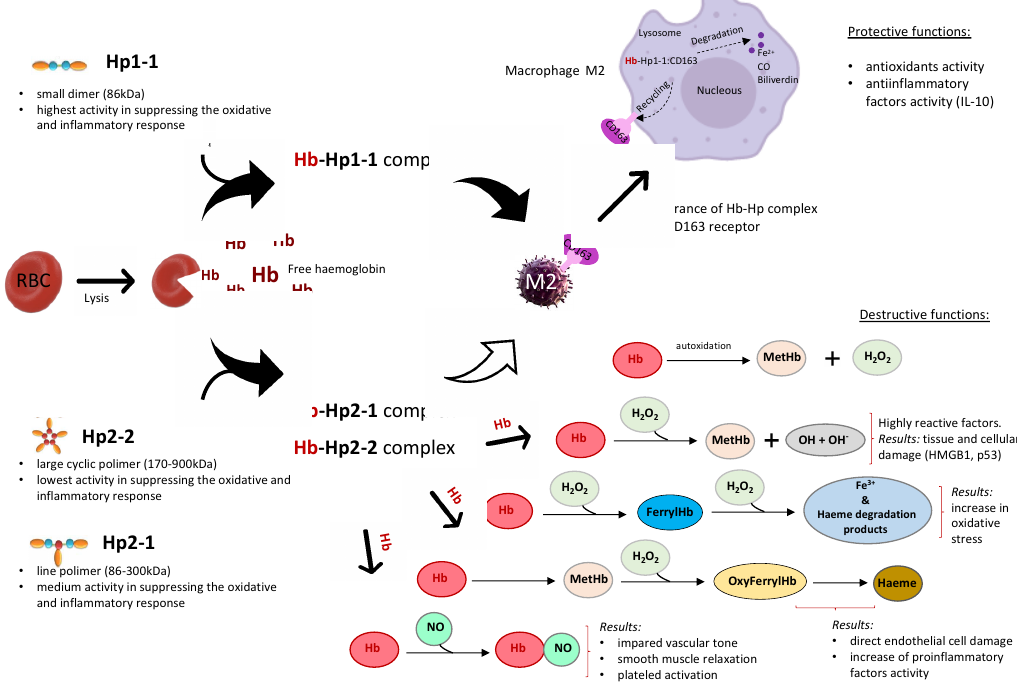
Figure 3. The proposed biological mechanism explaining the relationship between the haptoglobin phenotype and specific markers regulating inflammatory processes. In individuals with type 2 diabetic and Hp1-1 phenotype haptoglobin, hemoglobin (Hb) released intravascularly from red blood cells (RBC) is rapidly bound by haptoglobin (Hp1-1) protein to form an Hb–Hp1-1 complex that is cleared by scavenger receptor CD163 (on type anti-inflammatory macrophage M2). As a result, we obtain a protective effect through the increased production of anti-inflammatory (IL-10) and antioxidant factors. In people with type 2 diabetes and haptoglobin with the Hp2-1 and Hp2-2 phenotype, CD163 clearance is impaired and leads to increased oxidative stress. This results in an enhanced production of inflammatory factors which lead to destruction of the body’s tissues by apoptosis and necrosis of cells. It is known that chronic oxidative stress and the activity of pro-inflammatory factors may intensify the development of complications in people with type 2 diabetes, such as retinopathy, nephropathy, ischemic heart disease, atherosclerosis, stroke, and heart attack.